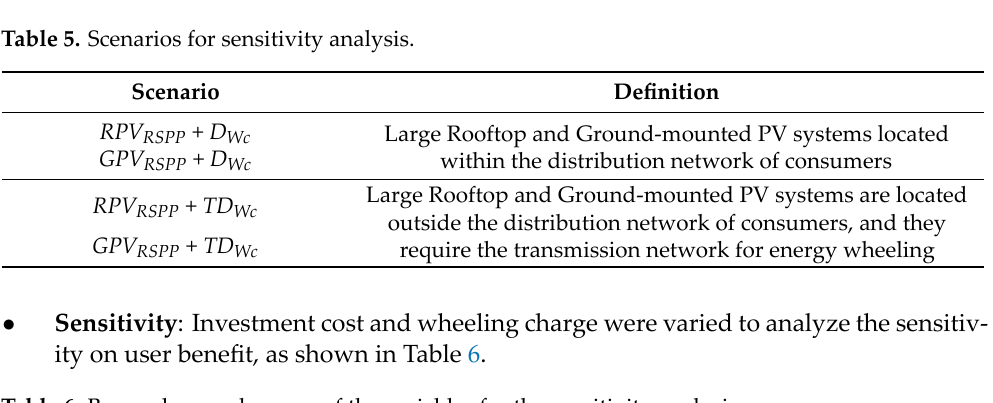
Table 6. Base values and ranges of the variables for the sensitivity